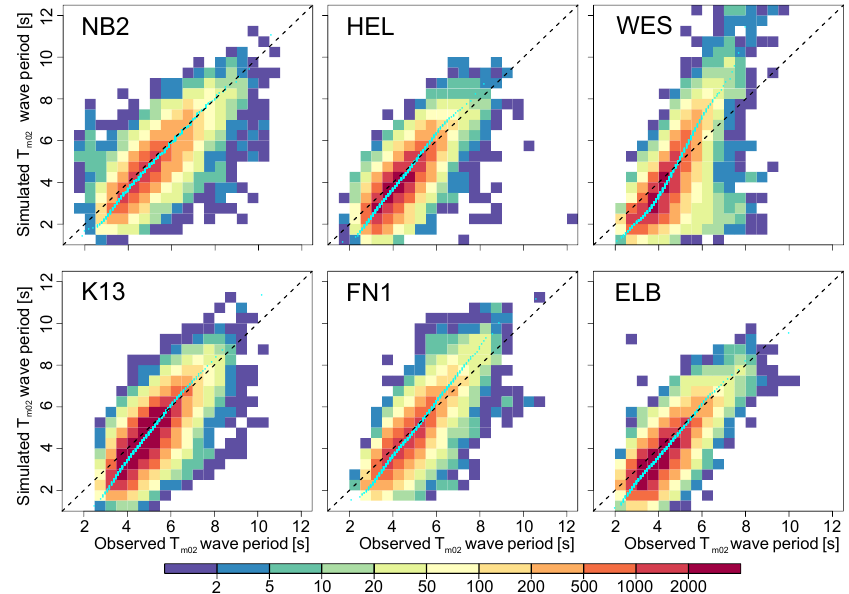
Figure 7. Scatter and quantile–quantile plot of T m02 wave period (in seconds) between in situ observation ( x -axis) and coastDat2 hindcast data ( y -axis). Coloured squares indicate the density of the data in each 0.5s × 0.5s bin. Coloured dots represent the percentile values of the quantile–quantile plots between observed and coastDat2 hindcast T m02 (cyan) wave periods. Note that the comparison is made for different periods according to data availability (see Table 1).